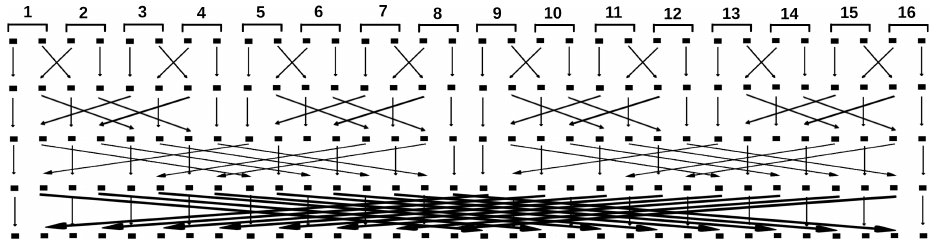
Figure 4. The data exchange scheme between 16 threads. In each thread the memory is divided into two parts. One stays, the other is transmitted to the other thread. Meanwhile the half of the memory of the other thread is written in its place. The numbers indicate the thread number, and the shaded squares indicate the memory block. This scheme corresponds to one in Figure 3. The positions of the coloured squares correspond exactly to the memory locations. The transmitted data are the energy values for the fixed